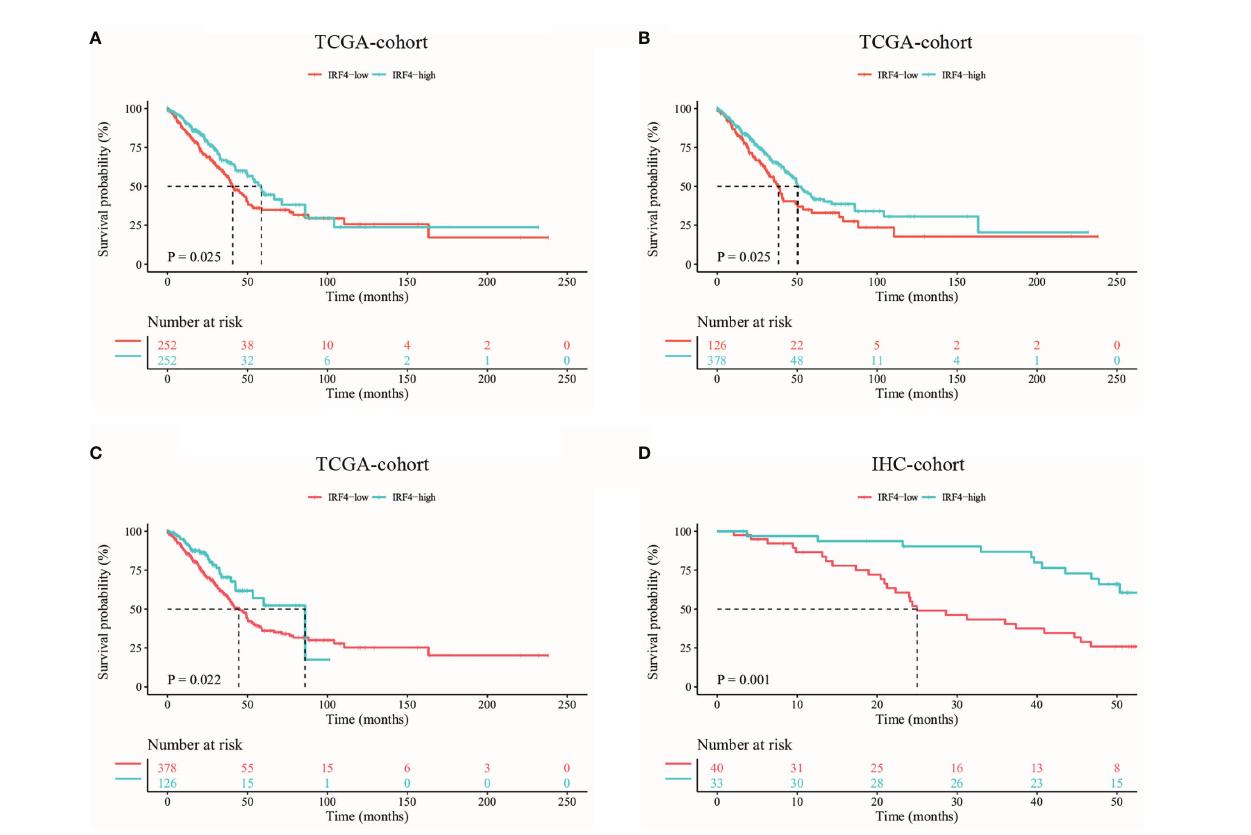
FIGURE 2 | Kaplan-Meier survival curves comparing the high and low IRF4 expression in LUAD. (A – C) Survival curves of OS in LUAD in TCGA database (n = 504). According to the median (A) and 25 th /75 th percentile (B, C) IRF4 mRNA expression, LUAD patients were divided into high and low IRF4 expression groups. (D) Survival curves of OS based on IRF4 expression in our IHC-cohort (n = 73). OS, overall survival; LUAD, Lung adenocarcinoma; IHC,